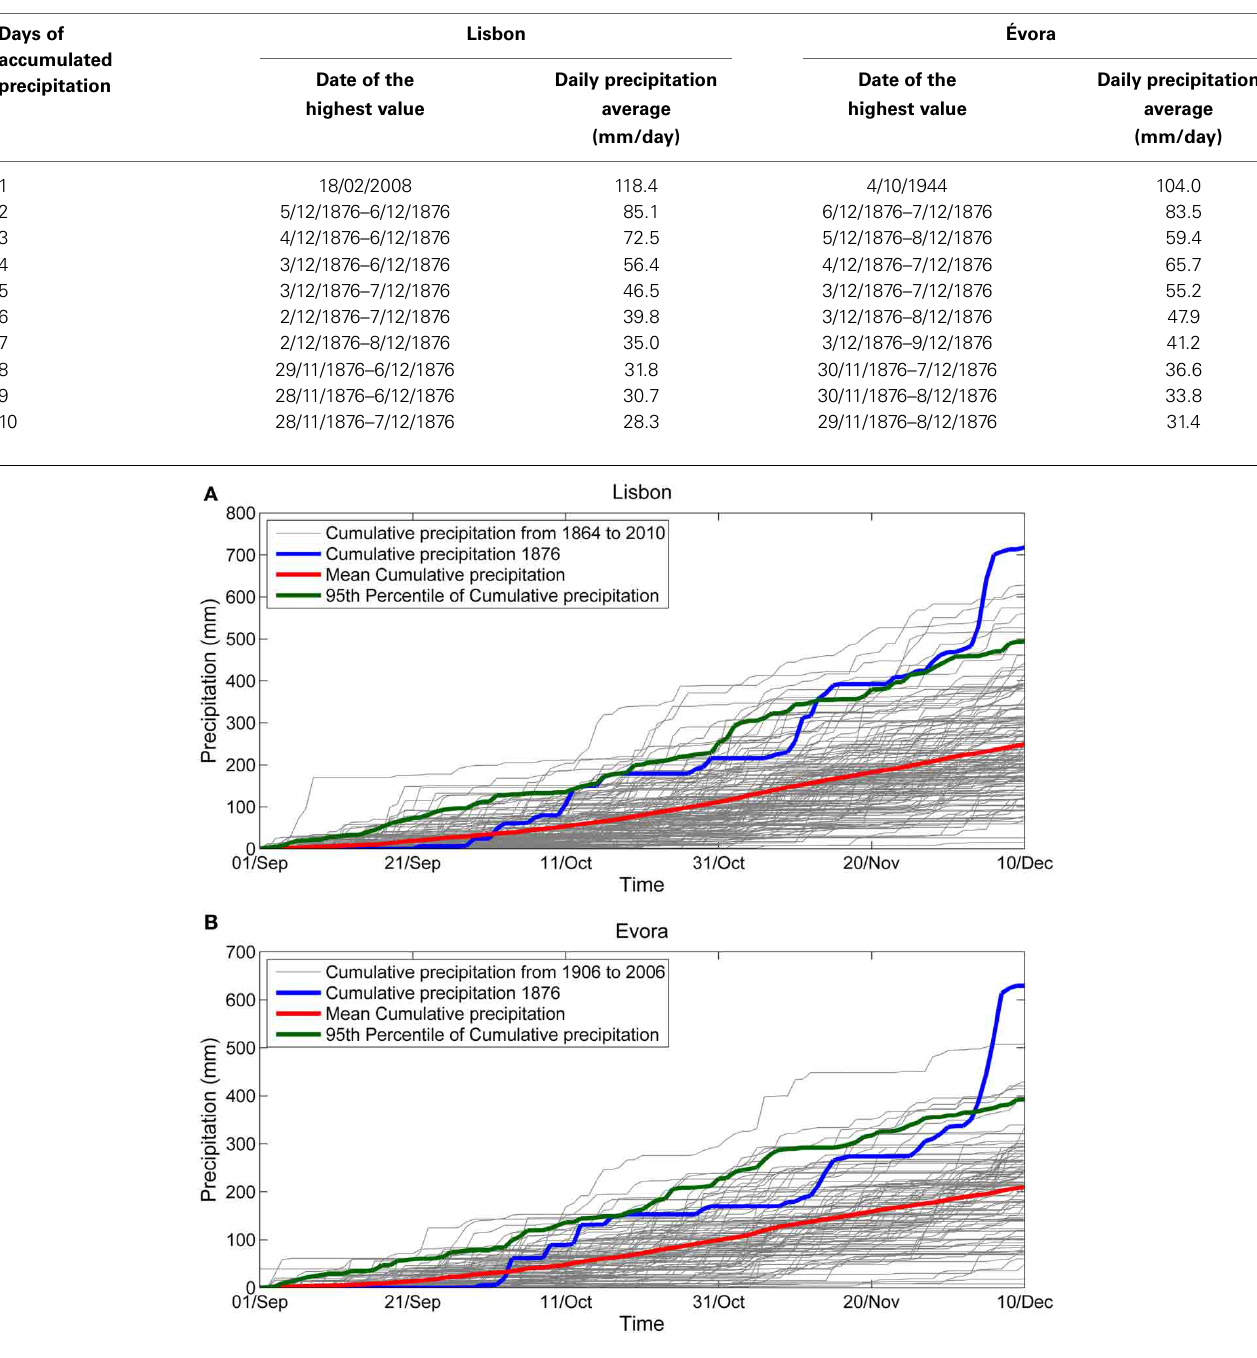
Table 2 | Values and time period for higher precipitation value from 1 to 10 days.